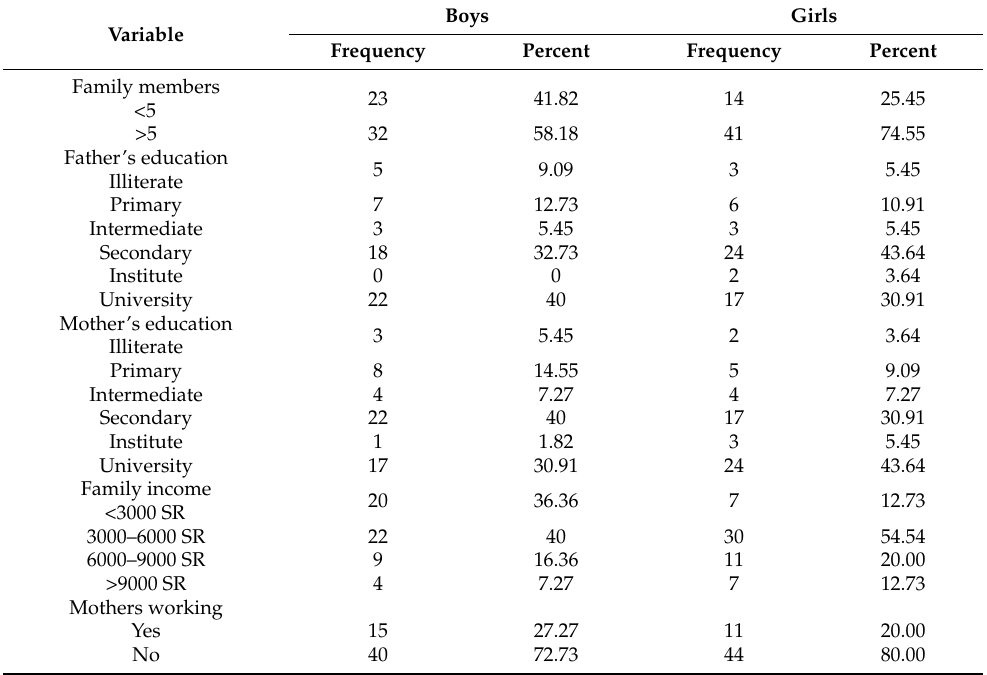
Table 1. Frequency distribution of Syrian children (boys and girls) according to socioeconomic data.